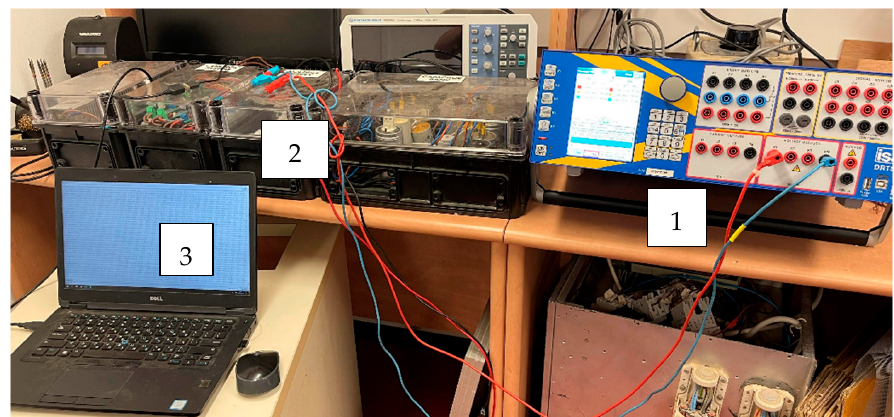
Figure 4. Test-bench for the verification different methods of the RMS estimation: 1—AC voltage source; 2—voltage transducer; 3—computer for data recording.